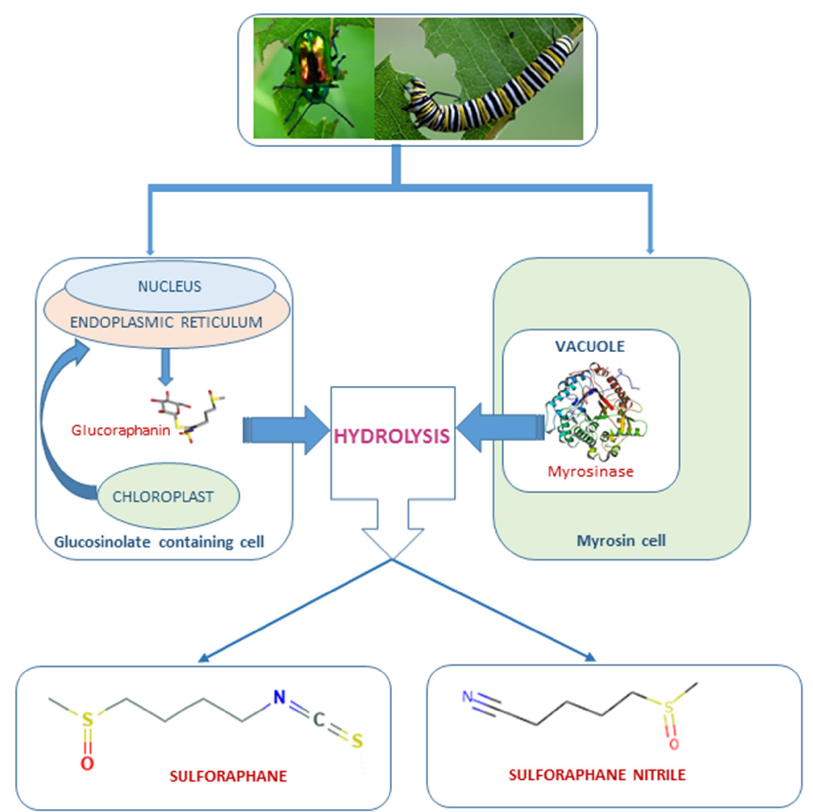
Figure 1. Myrosinase—glucoraphanin system in Brassicaceae plants. Glucosinolates are located in specialized glucosinolate-containing cells, while myrosinase is stored in the vacuoles of the myrosin cells. After mechanical disruption of plant tissue, the substrate and enzyme come in contact and the hydrolysis occurs, resulting in different products, among which it is found sulforaphane [7].